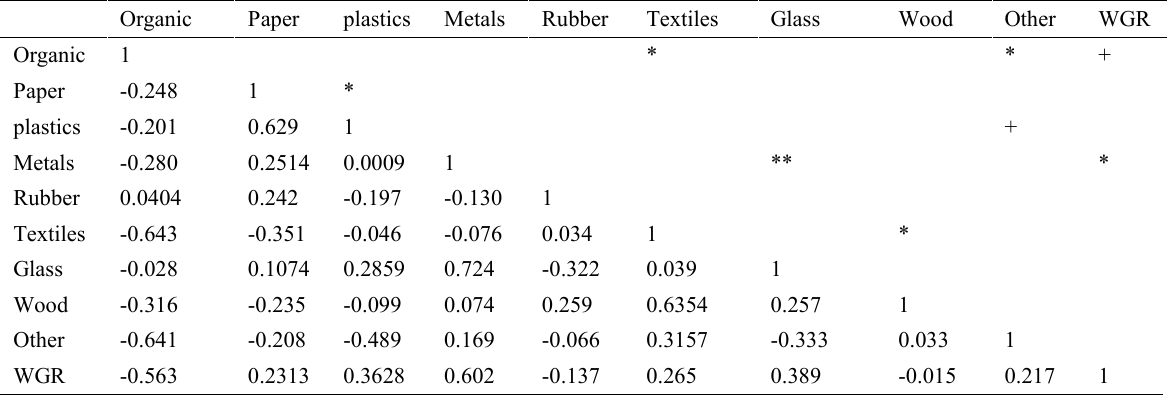
Table 6. Correlation matrix between MSW components from Spearman’s correlation Organic Paper plastics Metals